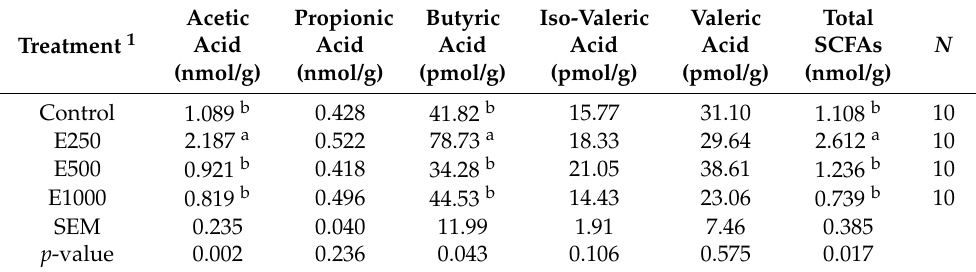
Table 6. Effect of glucose oxidase addition on the concentrations of short chain fatty acids (SCFAs) in the ileal digesta of broilers at 42 days of